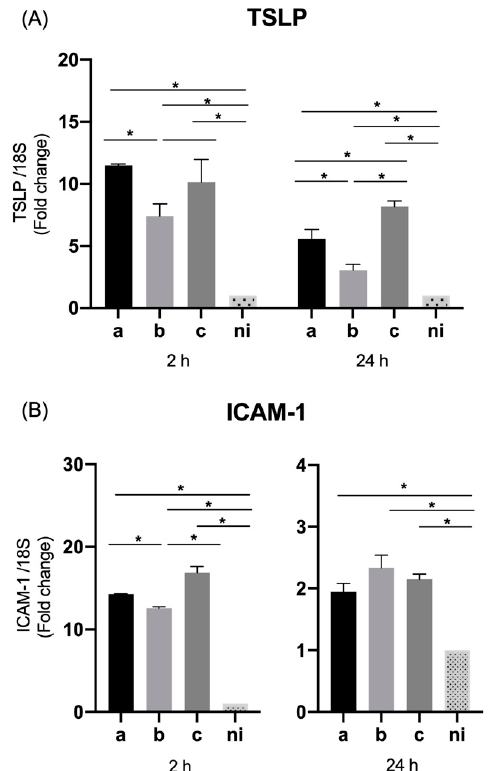
Figure 4. Thymic stromal lymphopoietin (TSLP) and ICAM-1 mRNA expression by A. actinomycetemcomitans -induced oral epithelial cells (OKF6/TERT2). Expression in oral epithelial cells infected at a MOI = 10 2 with strains ATCC ® 43717 TM (serotype a), ATCC ® 43718 TM (serotype b), and ATCC ® 43719 TM (serotype c), 2 and 24 h after infection. For relative expression, mRNA expression in non-infected (ni) oral epithelial cells was considered as 1, as a reference for fold-change in expression using 18S rRNA expression levels as a normalizing endogenous control. Data are represented as fold-change means and standard deviation of three independent experiments performed in duplicate. ( A ) TSLP. ( B ) ICAM-1. Asterisks were used to indicate a value of p considered statistically significant (* p < 0.05).